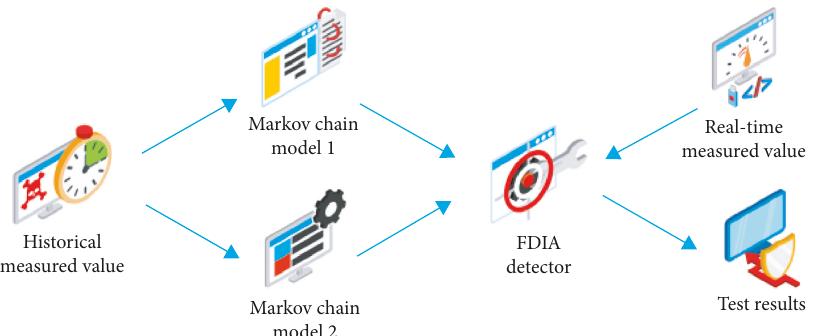
Figure 2: Structure of FDIA detection method based on double Markov chain.